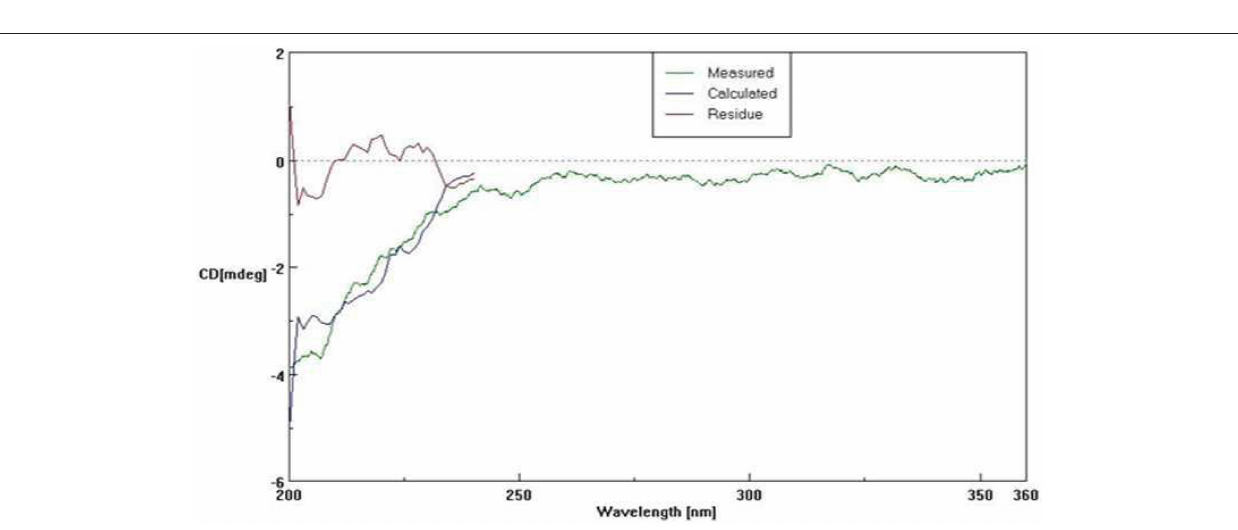
FIGURE 4 | Circular dichroism spectra of A. terreus NCFT 4269.10